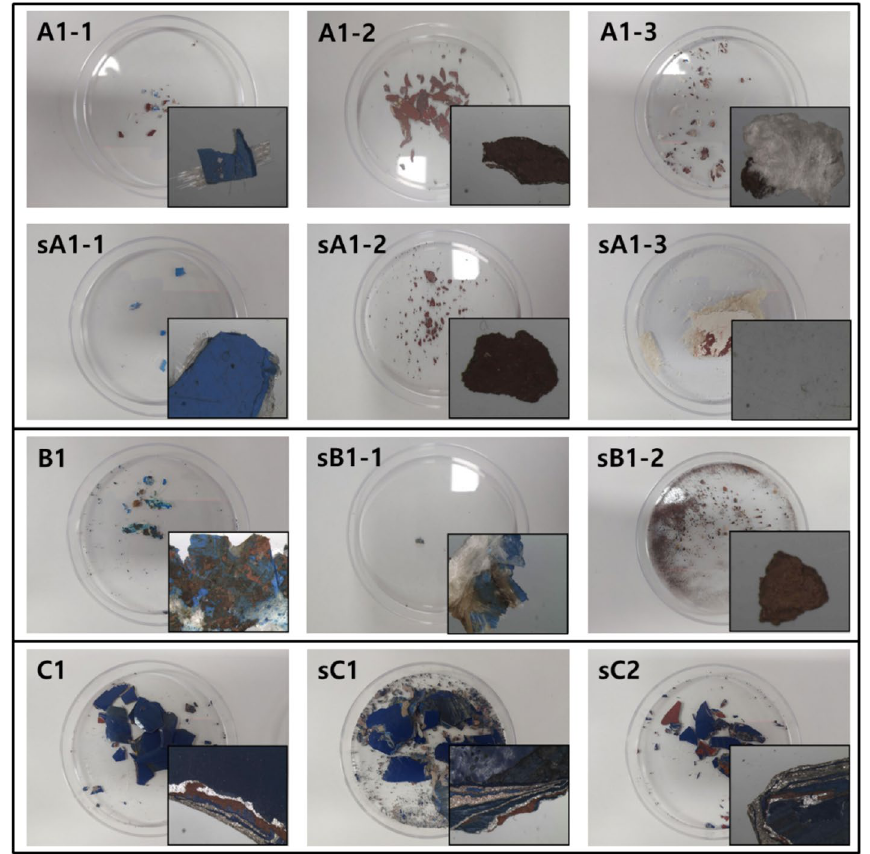
Figure 1. Paint collected from the actual collision